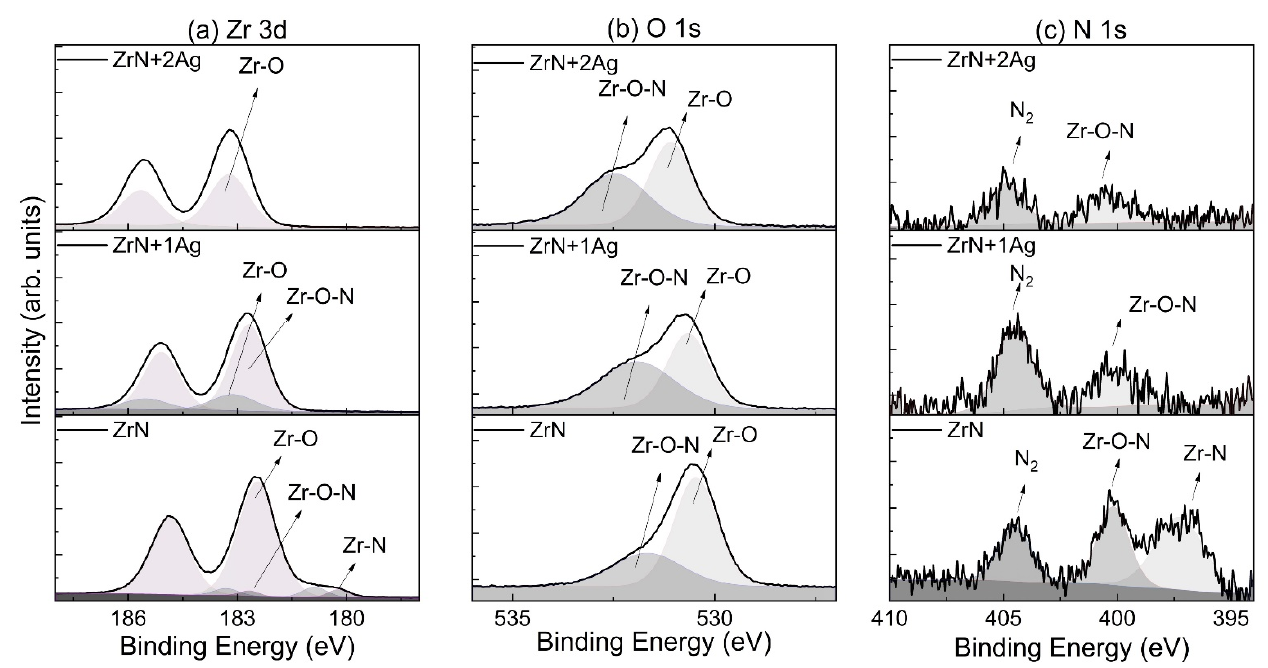
Figure 10. XPS spectra of ( a ) Zr 3d, ( b ) O 1s and ( c ) N 1s of the ZrN, ZrN1Ag, and ZrN2Ag coatings after the corrosion test.